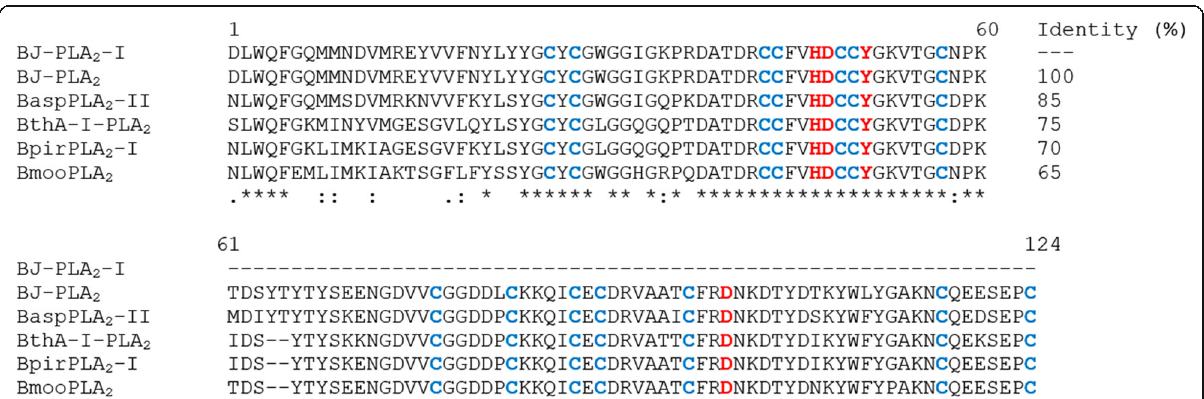
Fig. 3 Multiple alignment of the partial amino acid sequence of BJ-PLA 2 -I with sequences of other phospholipases A 2 from Bothrops venoms. Cysteine residues responsible for the formation of disulfide bonds are highlighted in blue and amino acid residues belonging to the catalytic site are in red. The toxins selected for alignment were: BJ-PLA 2 from B. jararaca (gi: 3914258) [28], BaspPLA 2 -II from B. asper (gi: 292630844) [58], BthA- I-PLA 2 from B. jararacussu (gi: 82211983) [18], BpirPLA 2 -I from B. pirajai (gi: 357580469) [32] and BmooPLA 2 from B. moojeni (gi: 403399514) [33]. (*) indicates positions with fully conserved amino acid residues; (:) indicates conservation of amino acid groups with high score; (.) indicates conservation of amino acid groups with a lower